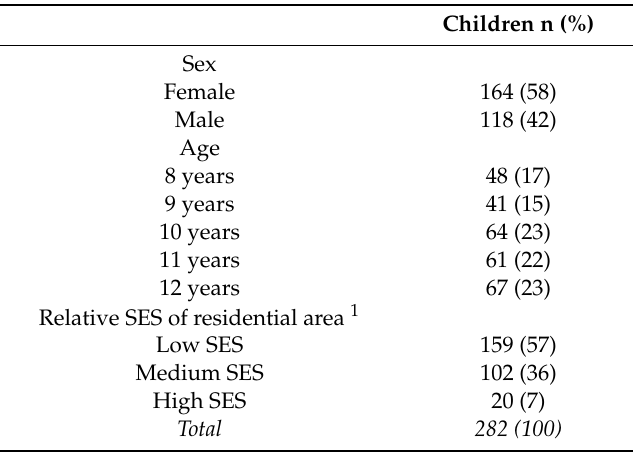
Table 2. Characteristics of the children’s